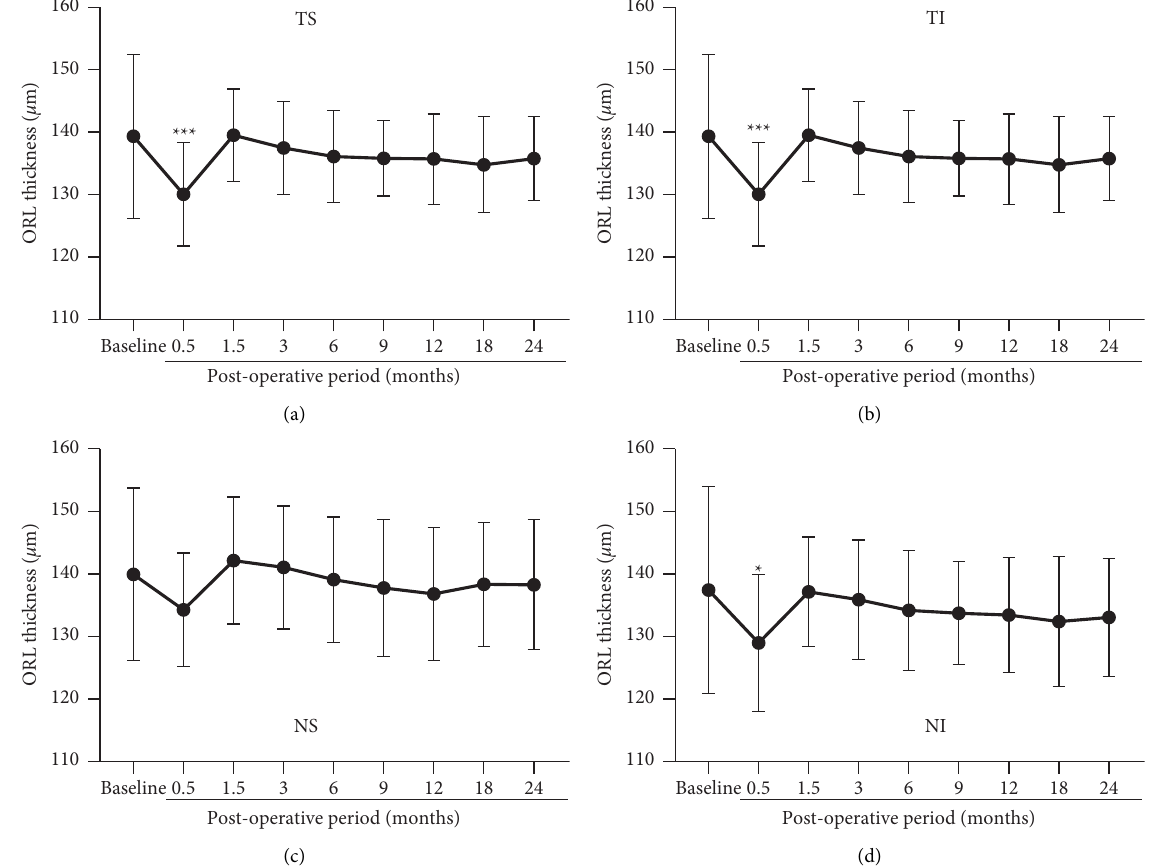
Figure 6: Mean thicknesses of the outer retinal layer (ORL) are plotted for the MH eyes treated with ILM peeling. In the temporal/superior (a), temporal/inferior (b), nasal/superior (c), and nasal/inferior quadrants (d), the ORL thickness of the treated eyes decreased at the month 0.5 with significant difference from that of the baseline (preoperative eyes) in all quadrants except for the NS. MH, macular hole; ILM, internal limiting membrane; TS, temporal/superior; TI, temporal/inferior; NS, nasal/superior; NI, nasal/inferior. Asterisks represent significant differences between the control and operated eyes. ∗ P < 0 . 05, ∗∗ P < 0 .